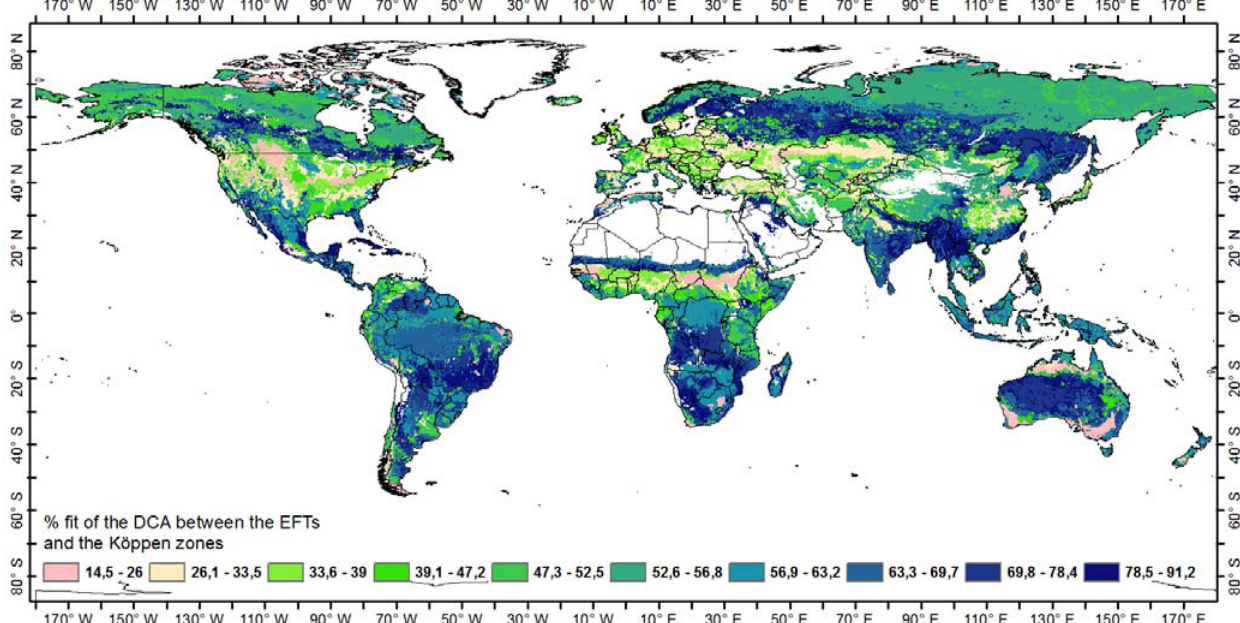
Figure 8. Percentage fit for the DCA of the EFTs with the Köppen zones. High values indicate good fit of the two datasets. White areas represent pixels without vegetation cover.